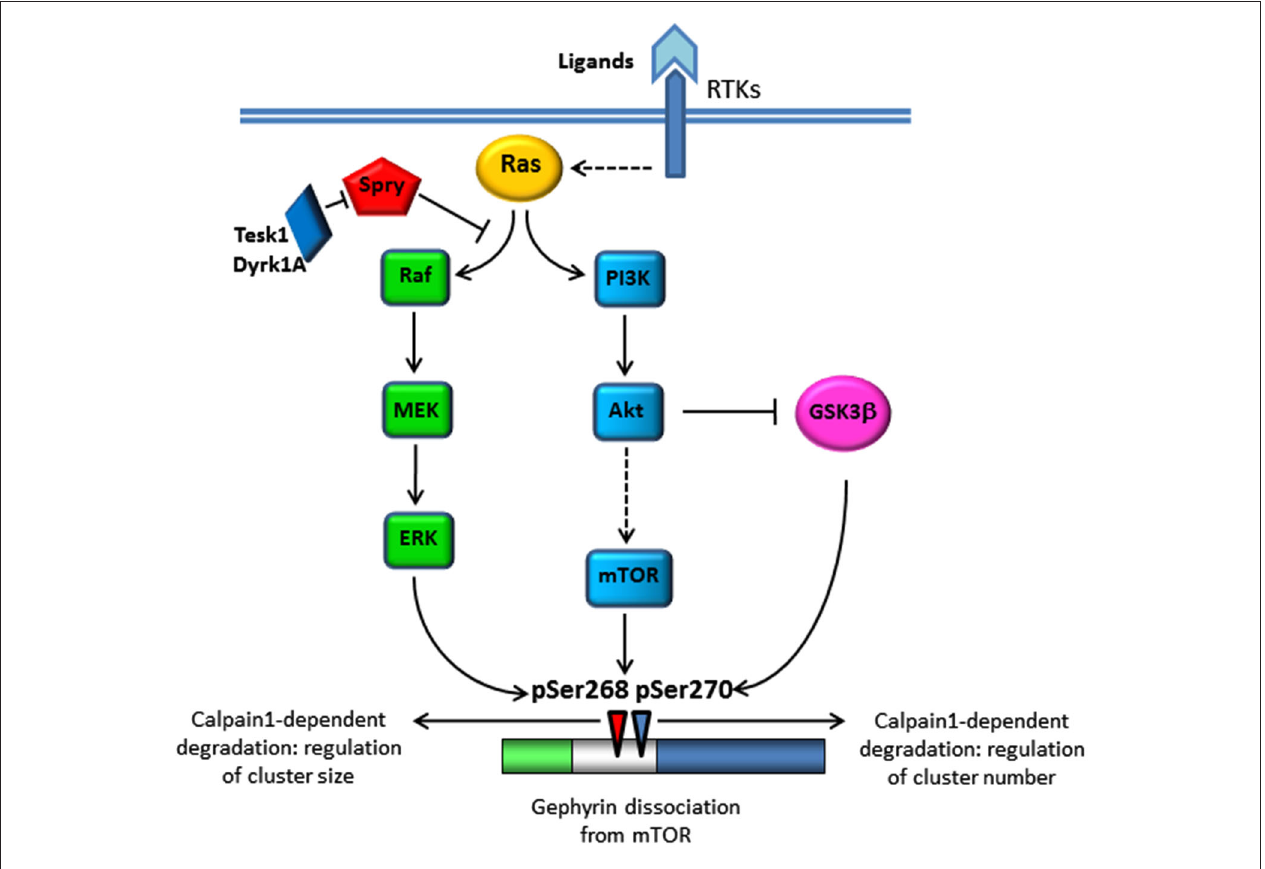
phosphorylation at Ser268 by ERK and gephyrin dissociation from mTOR. Akt also inhibits GSK-3 β activity, the kinase responsible of Ser270 phosphorylation. Gephyrin phosphorylated by these two kinases becomes substrate of calcium-dependent calpain